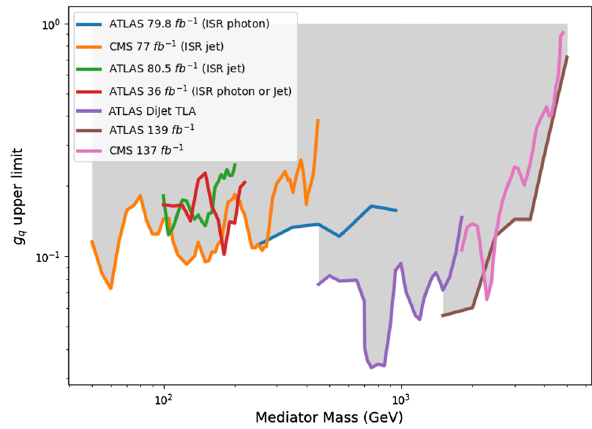
Fig. 1 Quark coupling upper limits from each dijet search included in our likelihood Eq. (27). For a given mediator mass, the 95% confidence dijet limit that we use in our likelihood is the one that is the most constraining (i.e. closest to the bottom of this